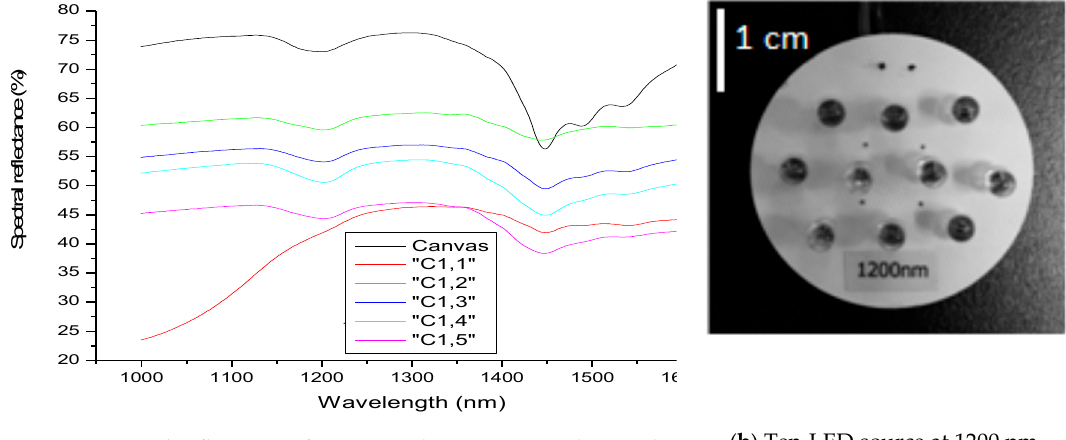
Figure 4. Measured reflectance signature depends on the spectral content of the source of illumination and the reflecting surface. ( a ) Measured reflectance of canvas and transparent color pixels; ( b ) Ten- LED source at 1200 nm